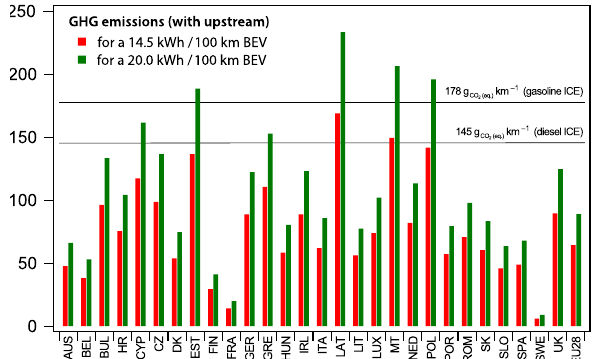
Figure 10. Greenhouse gas (GHG) emissions of electric vehicles in the countries of the European Union vs. gasoline and diesel cars, taking into account the electricity generation mix and cross-border electricity exchange.